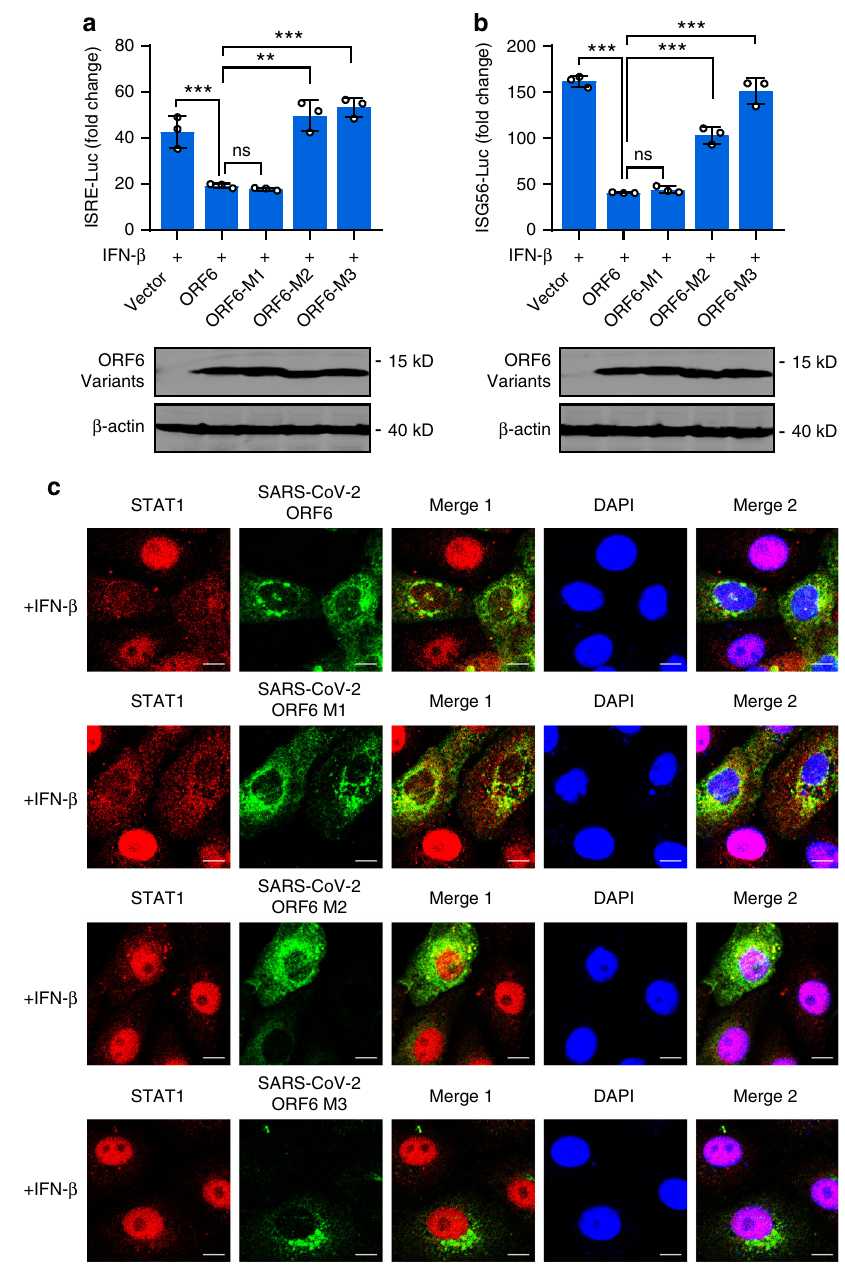
Fig. 7 ORF6 inhibits STAT1 nuclear translocation via its C-terminus. a , b Effect of SARS-CoV-2 ORF6 and its mutants on IFN- β -induced ISRE- and ISG56- promoter activation. HEK293T cells were transfected with an ISRE reporter plasmid ( a ) or an ISG56 reporter plasmid ( b ), along with a control plasmid or plasmids expressing wildtype or indicated SARS-CoV-2 ORF6 variants. At 24 h post-transfection, cells were treated with 800 U/ml IFN- β for 12 h, and luciferase activity was measured. Protein expression levels were detected by Western blot analyses. c Effect of SARS-CoV-2 ORF6 and its variants on IFN- β -induced STAT1 nuclear translocation. Vero cells were transfected with plasmids expressing wildtype ORF6 or indicated ORF6 variants. At 24 h post- transfection, cells were treated with 1000 U/ml of human IFN- β for 30 min and stained with indicated antibodies. Merge 1 and Merge 2 indicate the merged red and green channels and the merged red, green, and blue channels, respectively. Scale bar, 10 μ m. All experiments were done at least twice, and one representative is shown. Error bars indicate SD of technical triplicates, ** P < 0.01, and *** P < 0.001, ns not signi fi cant, two-tailed Student ’ s t -test. Source data are provided as a Source Data fi